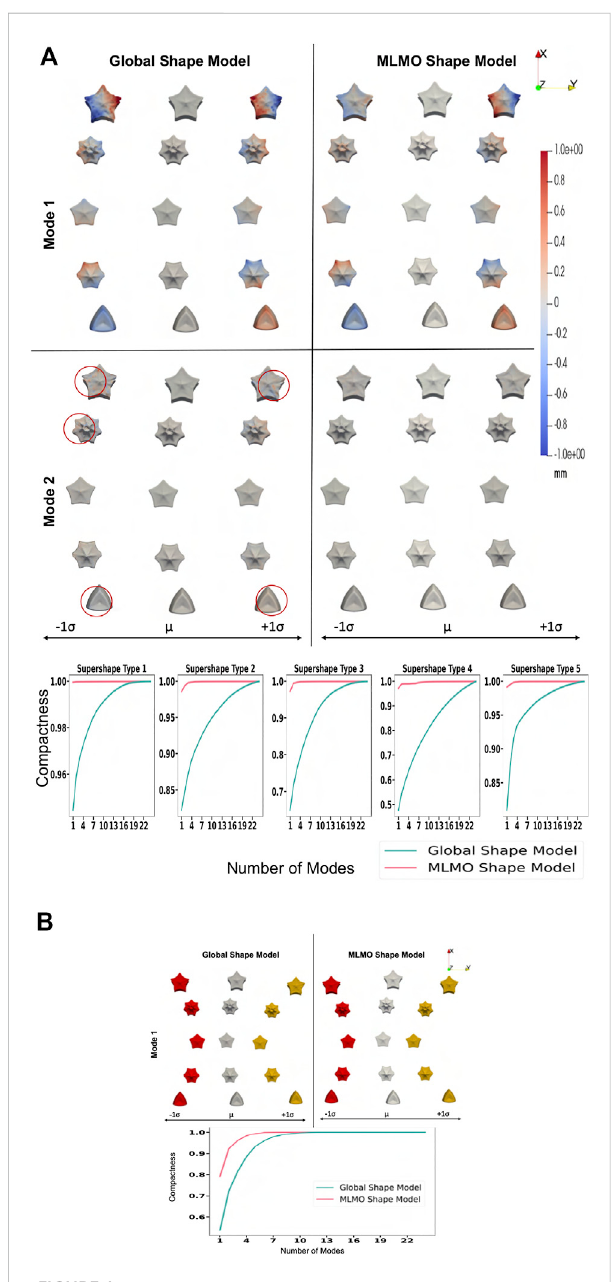
FIGURE 1 Proof of concept experiment results — Modes of variation and compactness metric. (A) Within-object subspace. (B) Between- objects